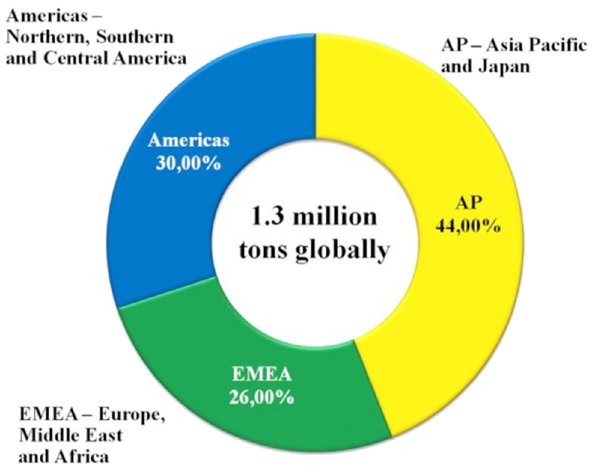
Figure 1: Global, annual demand for petroleum plasticisers as per regions of the world.